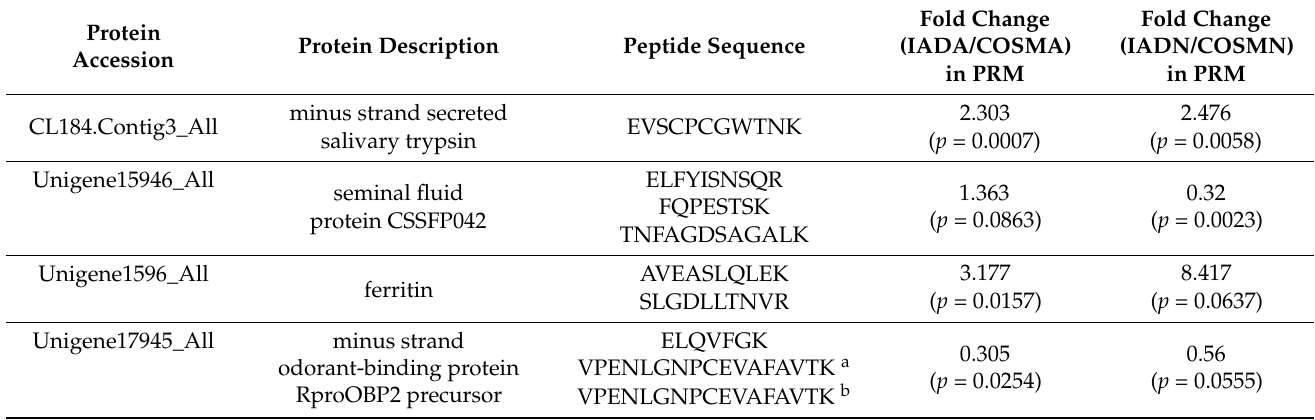
Table 1. Confirmation of DEPs detected in iTRAQ analysis using PRM analysis.